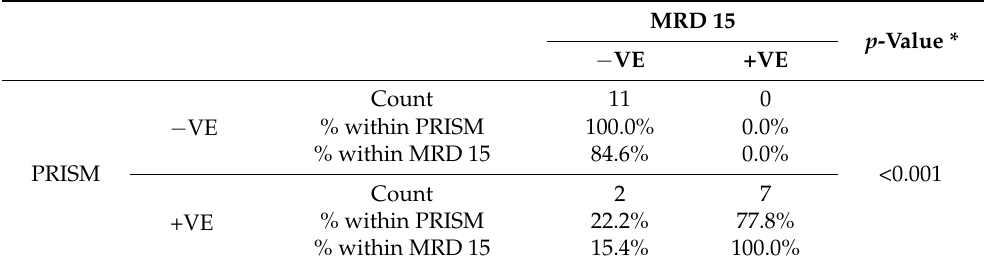
Table 6. Comparison between the immunologic remission status at day 15 and the PRISM combination.